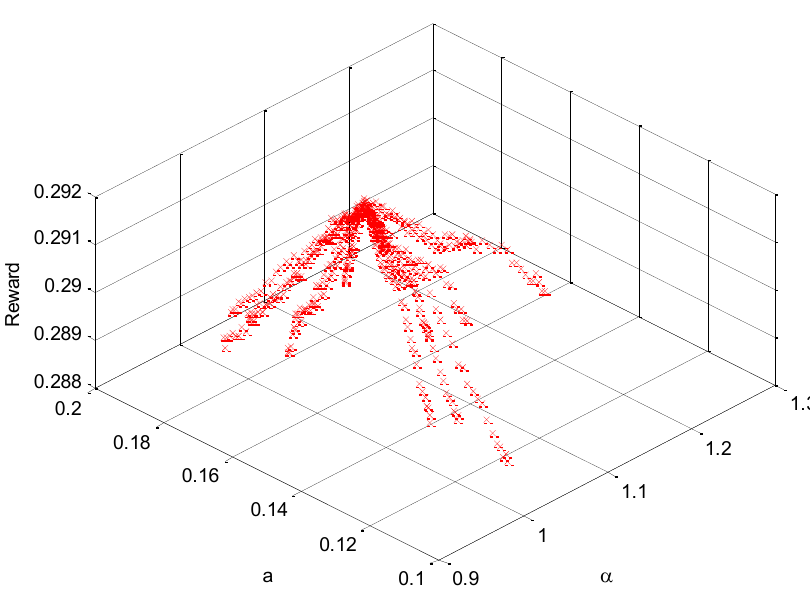
Figure 4. Mean Reward vs. optimization parameters.